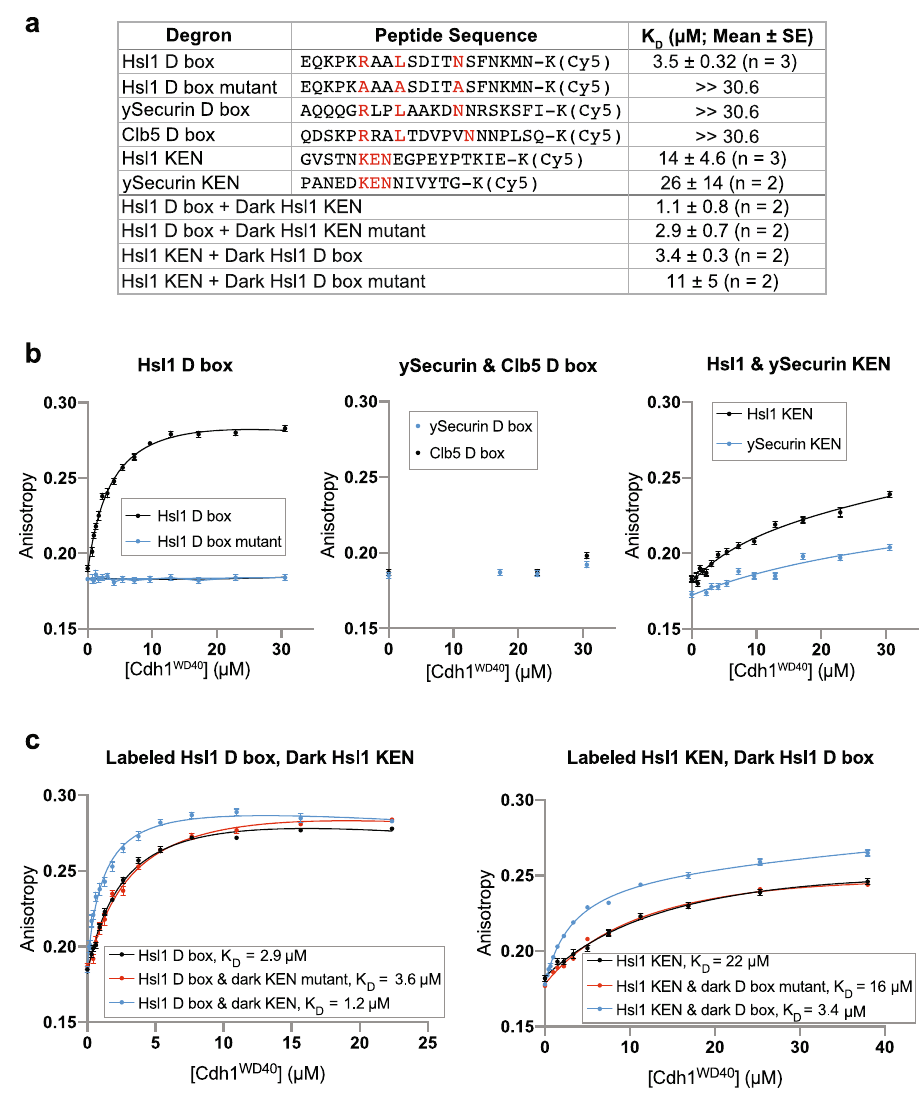
Fig. 1 Analysis of degron af fi nity by fl uorescence anisotropy. a List of Cy5-labeled degron peptides tested in anisotropy experiments with Cdh1 WD40 . Column at right lists mean K D values from multiple experimental replicates, including the representative experiments shown in b and c . b Fluorescence anisotropy experiments with the peptides listed in a . 10 nM peptide was incubated with up to 30.6 µ M Cdh1 WD40 . Data points represent mean ± SE ( n = 10 reads per reaction). In this experiment, K D values were as follows: Hsl1 D box, 4 µ M; Hsl1 KEN, 12 µ M; ySecurin KEN, 40 µ M. Mean K D values from 2 or 3 independent experiments are shown in a . c Binding was measured with labeled degron peptide (10 nM) in the absence (black) or presence of an unlabeled version of the other degron (100 µ M), either wild-type (blue) or mutated at key residues (red). Note that 100 µ M KEN peptide is not completely saturating. Data points represent mean ± SE ( n = 10 reads per reaction). Insets indicate K D values in this experiment. Mean K D values from two independent replicates are shown in a . Source data are provided as a Source Data fi